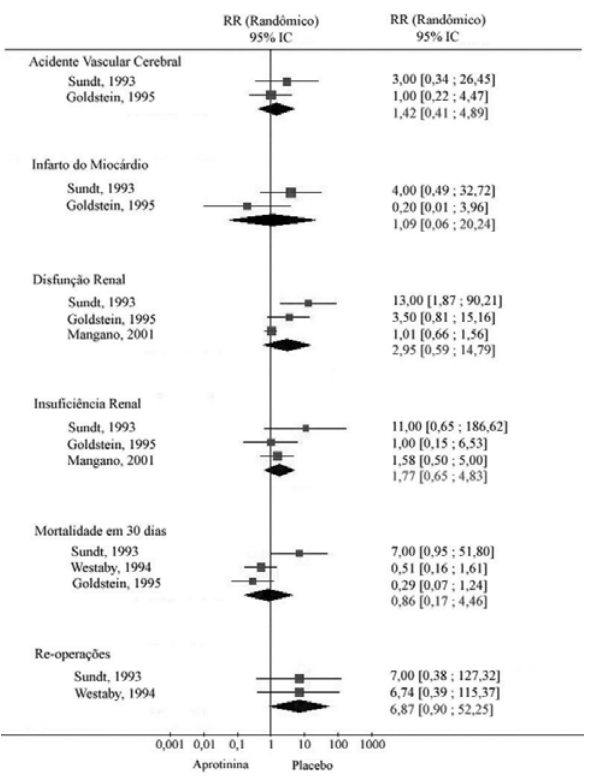
Fig. 6 - Metanálise das variáveis contínuas dos estudos que administraram alta dose de aprotinina. RR = risco relativo; IC = intervalo do confiança